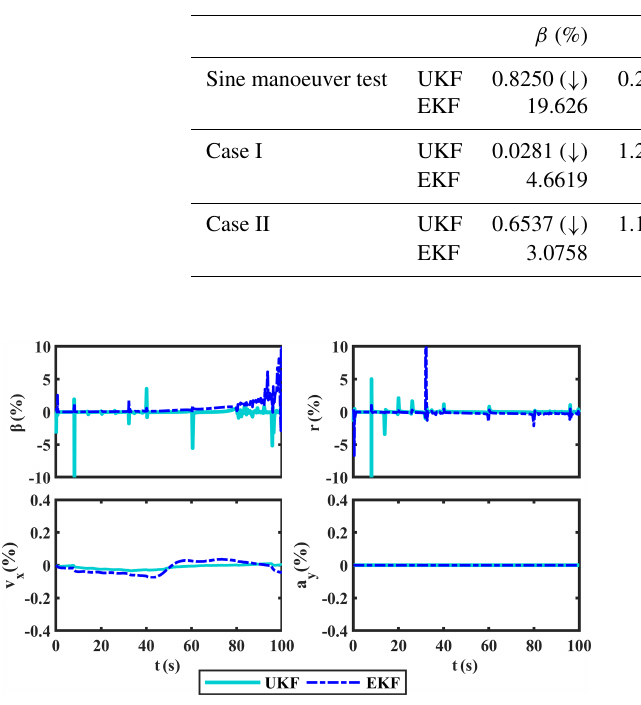
Figure 8. The relative error curves of β , r , v x , and a y under the sine manoeuver test.